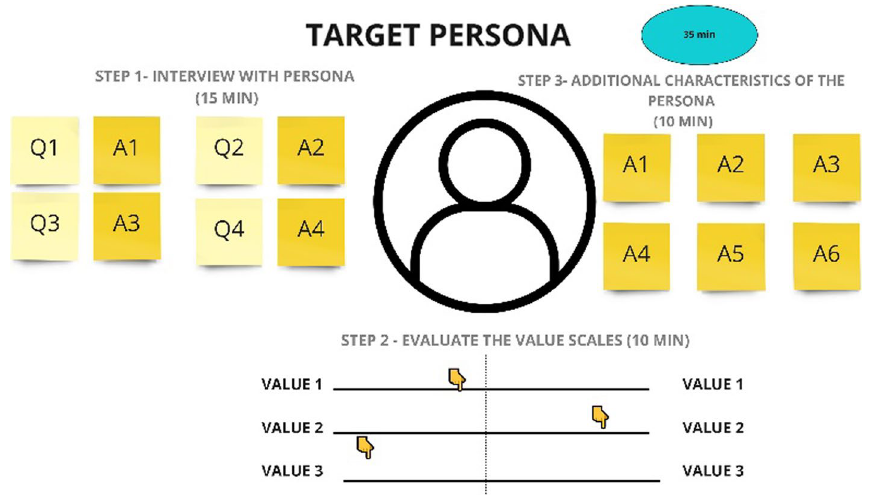
Fig. 5 Step 1: “Warm‑up” of the 4‑step sequence of idea management to reinvent values (source: created by